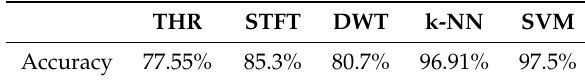
Table 5. Accuracy of coarse-grained walk